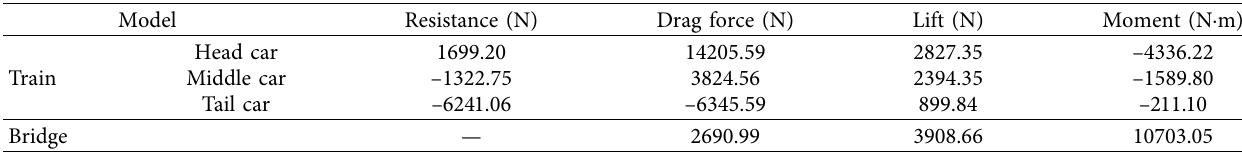
Table 2: Wind loads of the train and wind loads of the bridge per unit